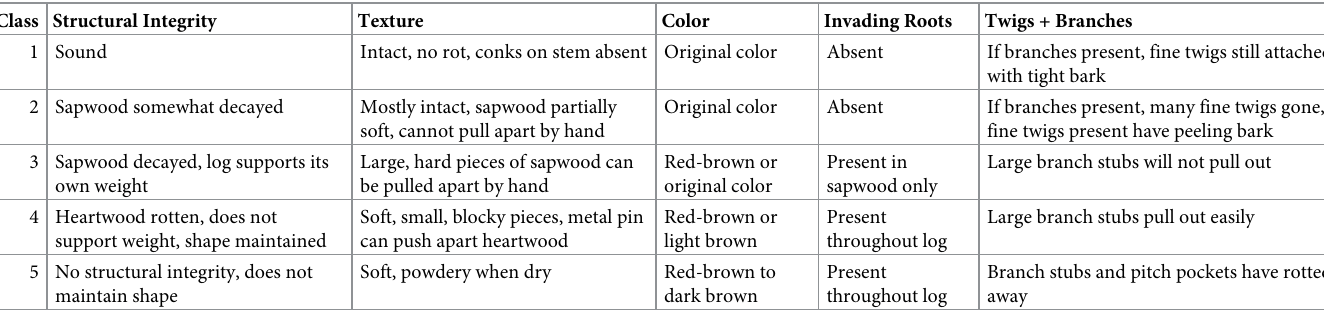
Table 1. Decay class designations for coarse woody debris [after